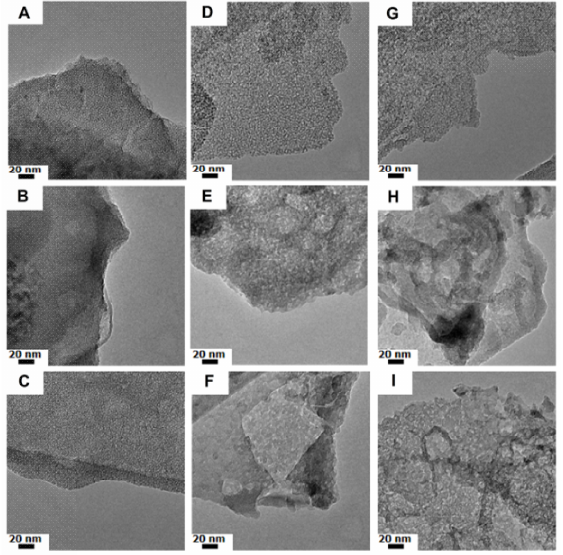
Figure 8. Transmission electron microscopy image of mSiO 2 after LDH immersed in water ( A – C ), the PBS solution ( D – F ) and medium ( G – I ) for 24 h (images A , D , G ), 48 h ( B , E , H ), and 72 h ( C , F , I ).